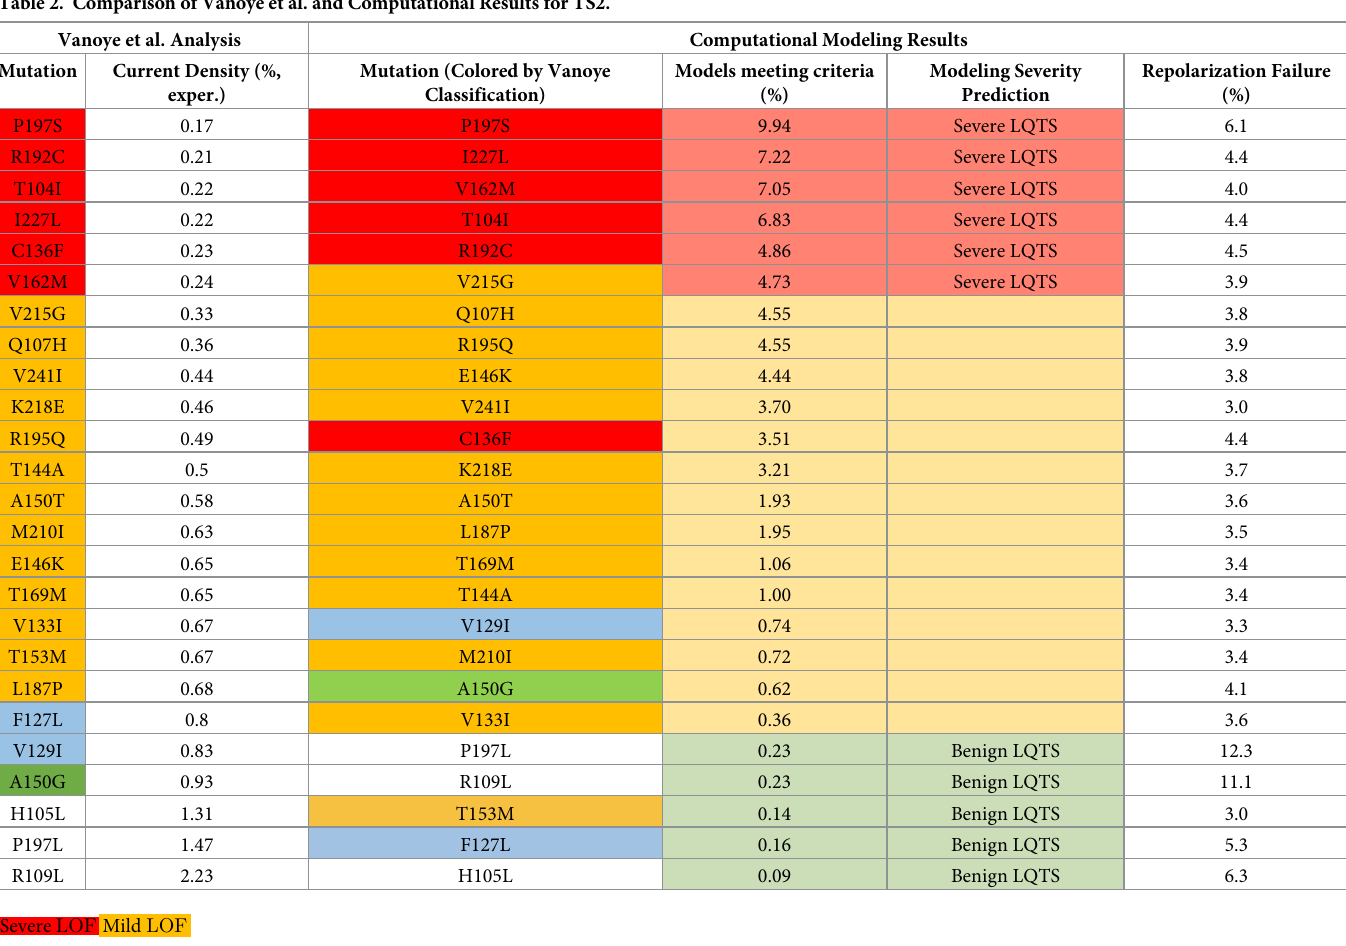
Table 2. Comparison of Vanoye et al. and Computational Results for TS2. Vanoye et al. Analysis Current Density (%, exper.)